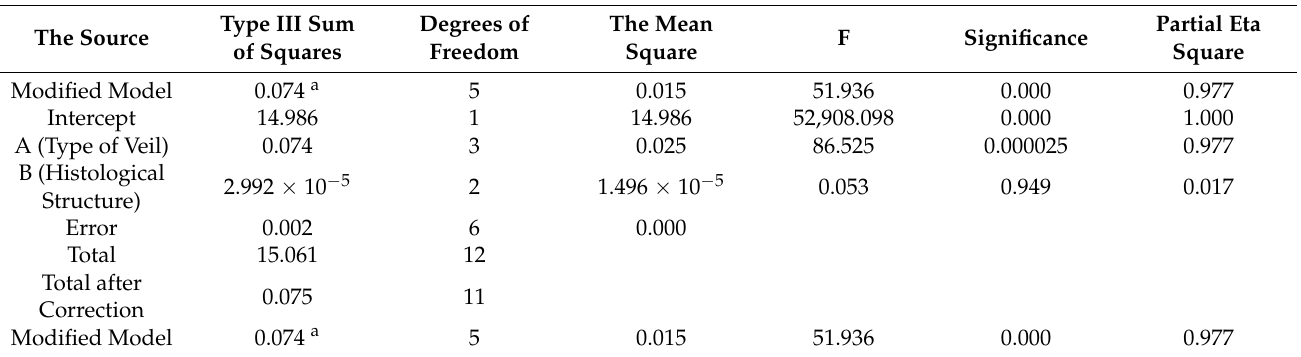
Table 5. Inter-subject effect test of blood-flow enhancement multiple of human-surface-skin microcir- culation.